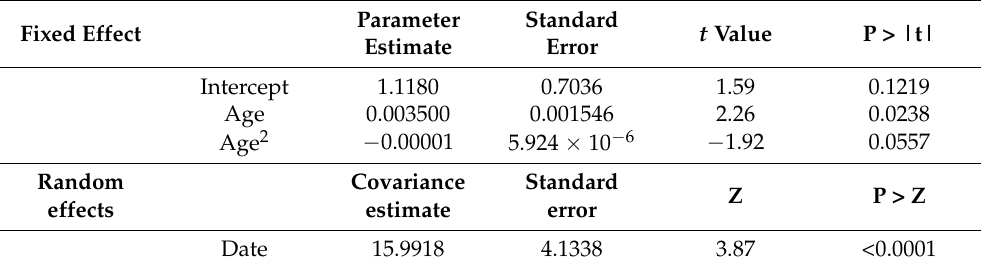
Table 5. Parameter Estimates and Level of Significance of the Generalized Linear Mixed Model for the Survival Rate in the Death